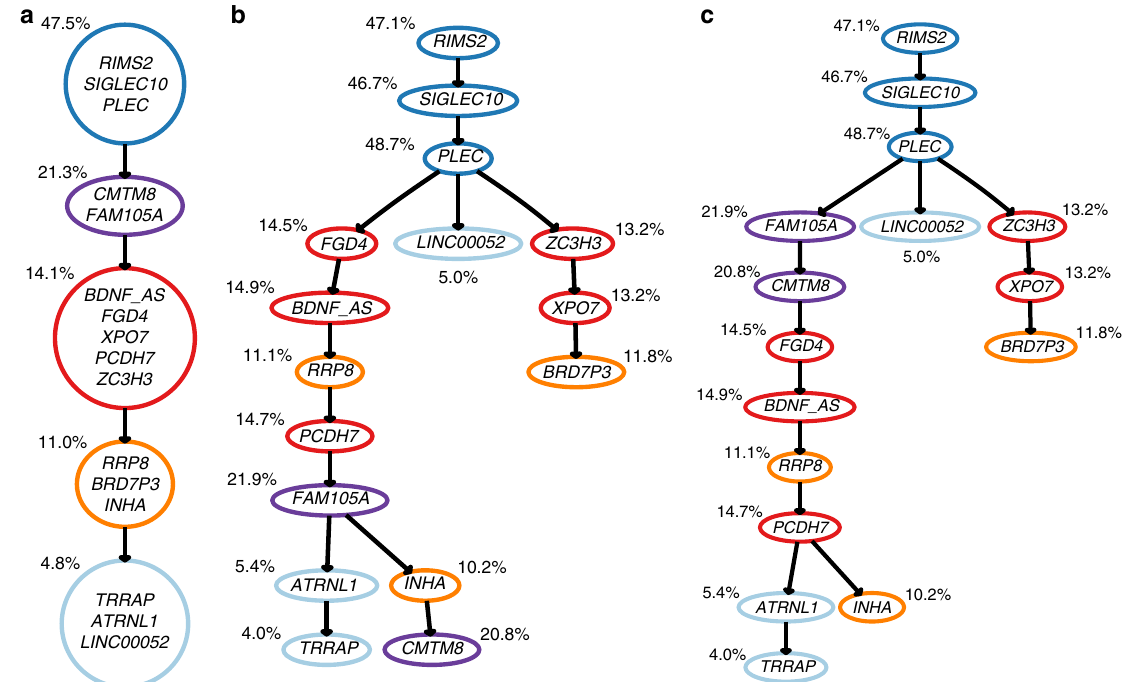
Fig. 6 Mutation histories inferred from bulk and single-cell sequencing data for a patient with childhood ALL (Patient 2 of the study in ref. 37 ): a one of the multiple clonal trees compatible with the bulk-sequencing data (inferred with CTPsingle 20 ). Clones are annotated with the mean VAF of the mutations newly acquired by the clone. Several other compatible trees are depicted in Supplementary Fig. 28. b Mutation tree inferred with SCITE 28 from single-cell panel sequencing data of 115 cells. The colouring scheme follows from the clustering in the CTPsingle tree. Mutations are annotated with the VAFs observed in the bulk sample. c Mutation tree inferred with B-SCITE from the combined single-cell and bulk data. B-SCITE mutation trees can be compressed to clonal trees (Supplementary Fig.